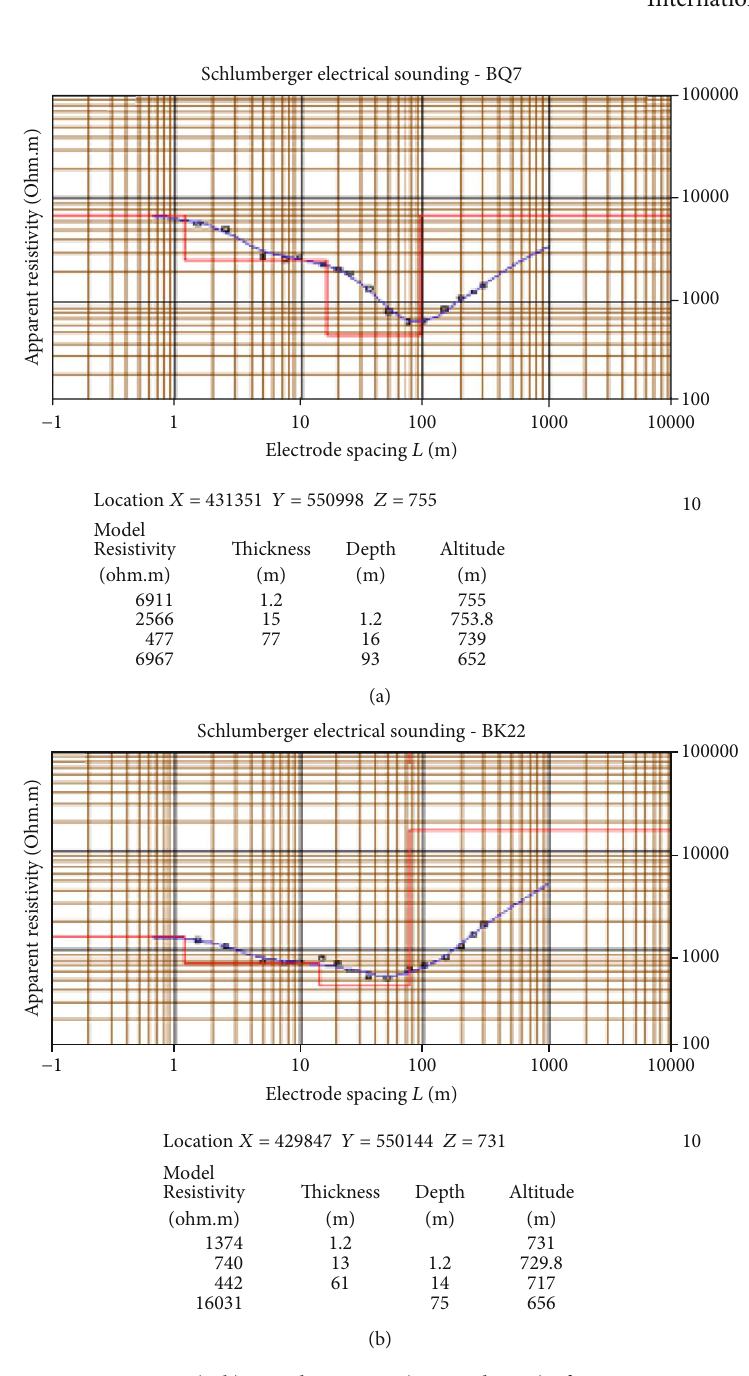
and BK ) of type 7 22